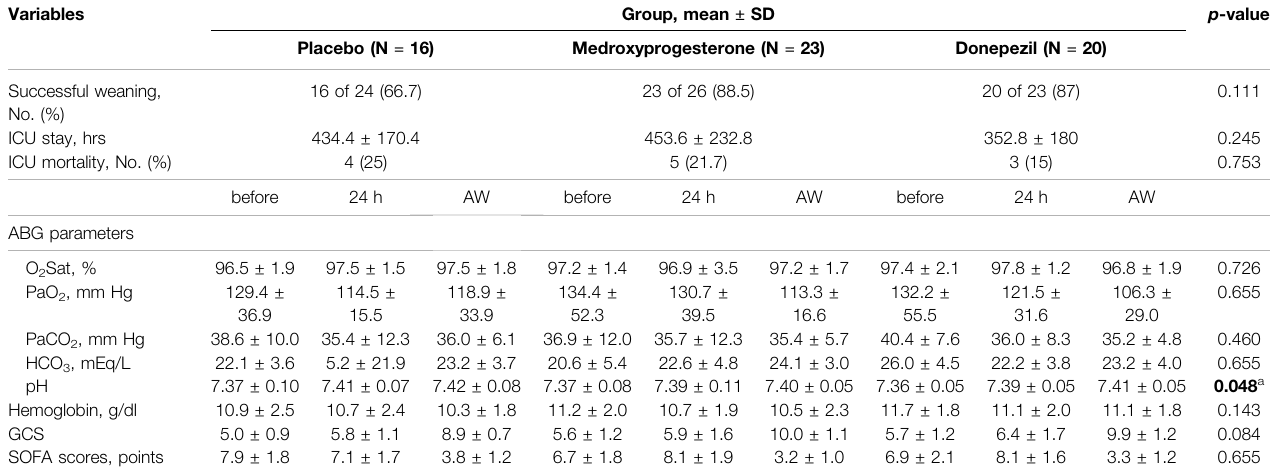
TABLE 3 | Secondary outcomes in successfully weaned patients before, after 24 h, and when weaning happened. Variables Group, mean ± SD p -value Placebo (N = 16) Medroxyprogesterone (N = 23) Donepezil (N = 20) Successful weaning, 16 of 24 (66.7) No. (%)